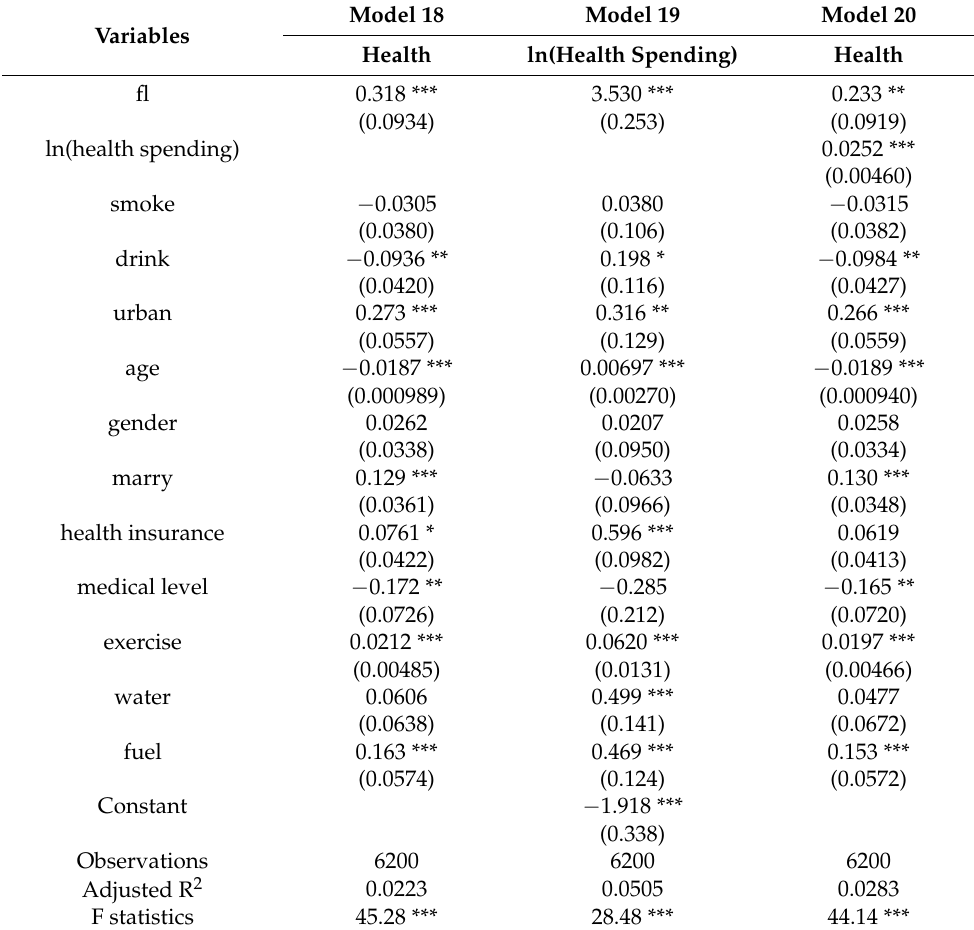
Table 9. The mediating effect of financial literacy on the residents’ health: health